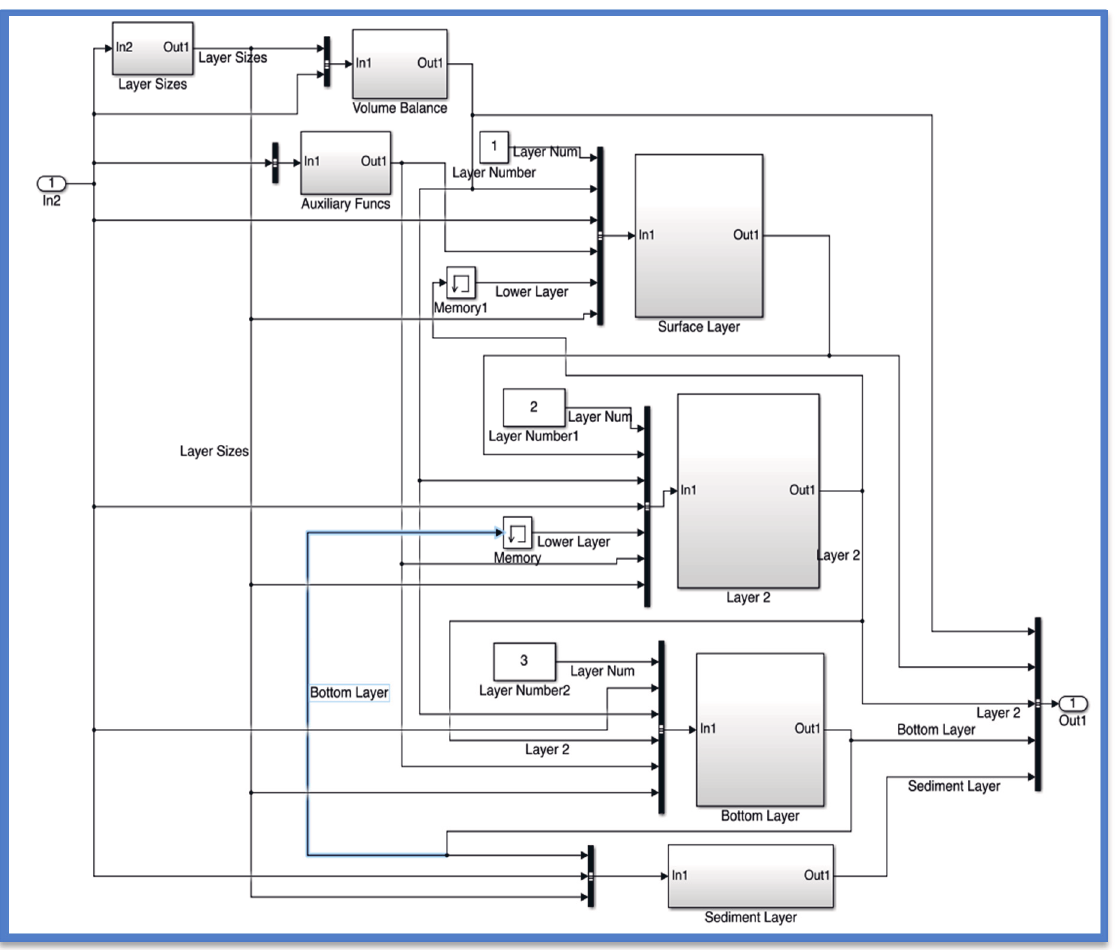
Figure 7. W2_SL model of segment 1. Separate subsystems (shown with boxes) calculate the heat and mass balances for each layer or the volume balance for all three layers. Lines and arrows indicate data transfers between